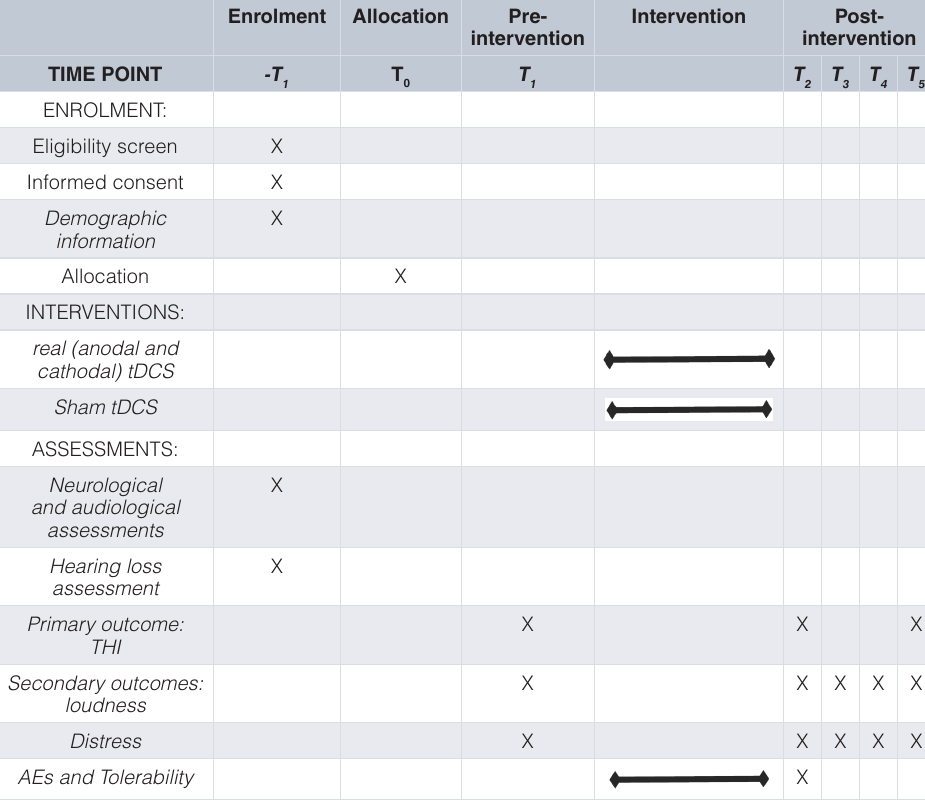
Table 2 represents the SPIRIT schematic protocol of the study and timing of the assessments.